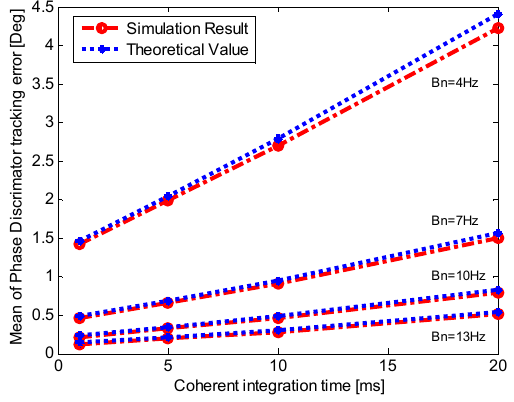
Figure 7. Mean of the output of PD (phase discriminator) when p = 50 m/s 3 .